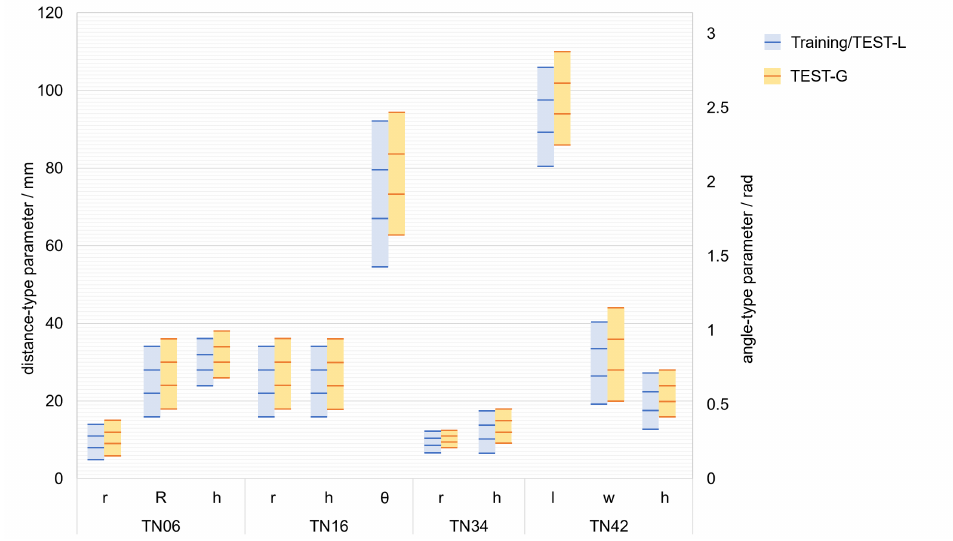
Figure 3. Overview of parameter value distribution of the part objects, where θ is angle-type parameter and others are distance-type